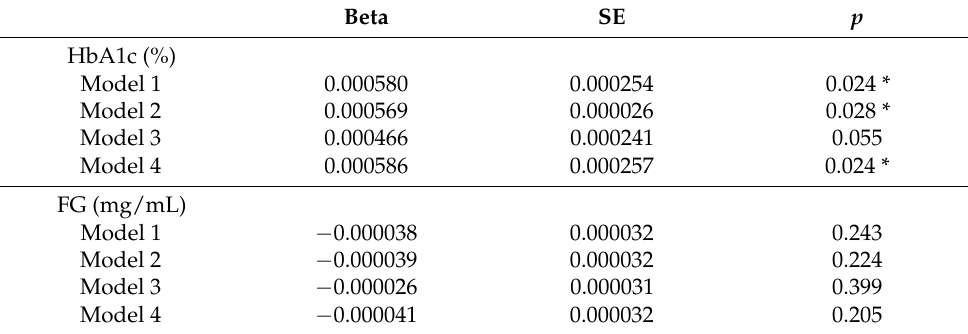
Table 5. Association of EPA + DHA intake with HbA1c and FG.